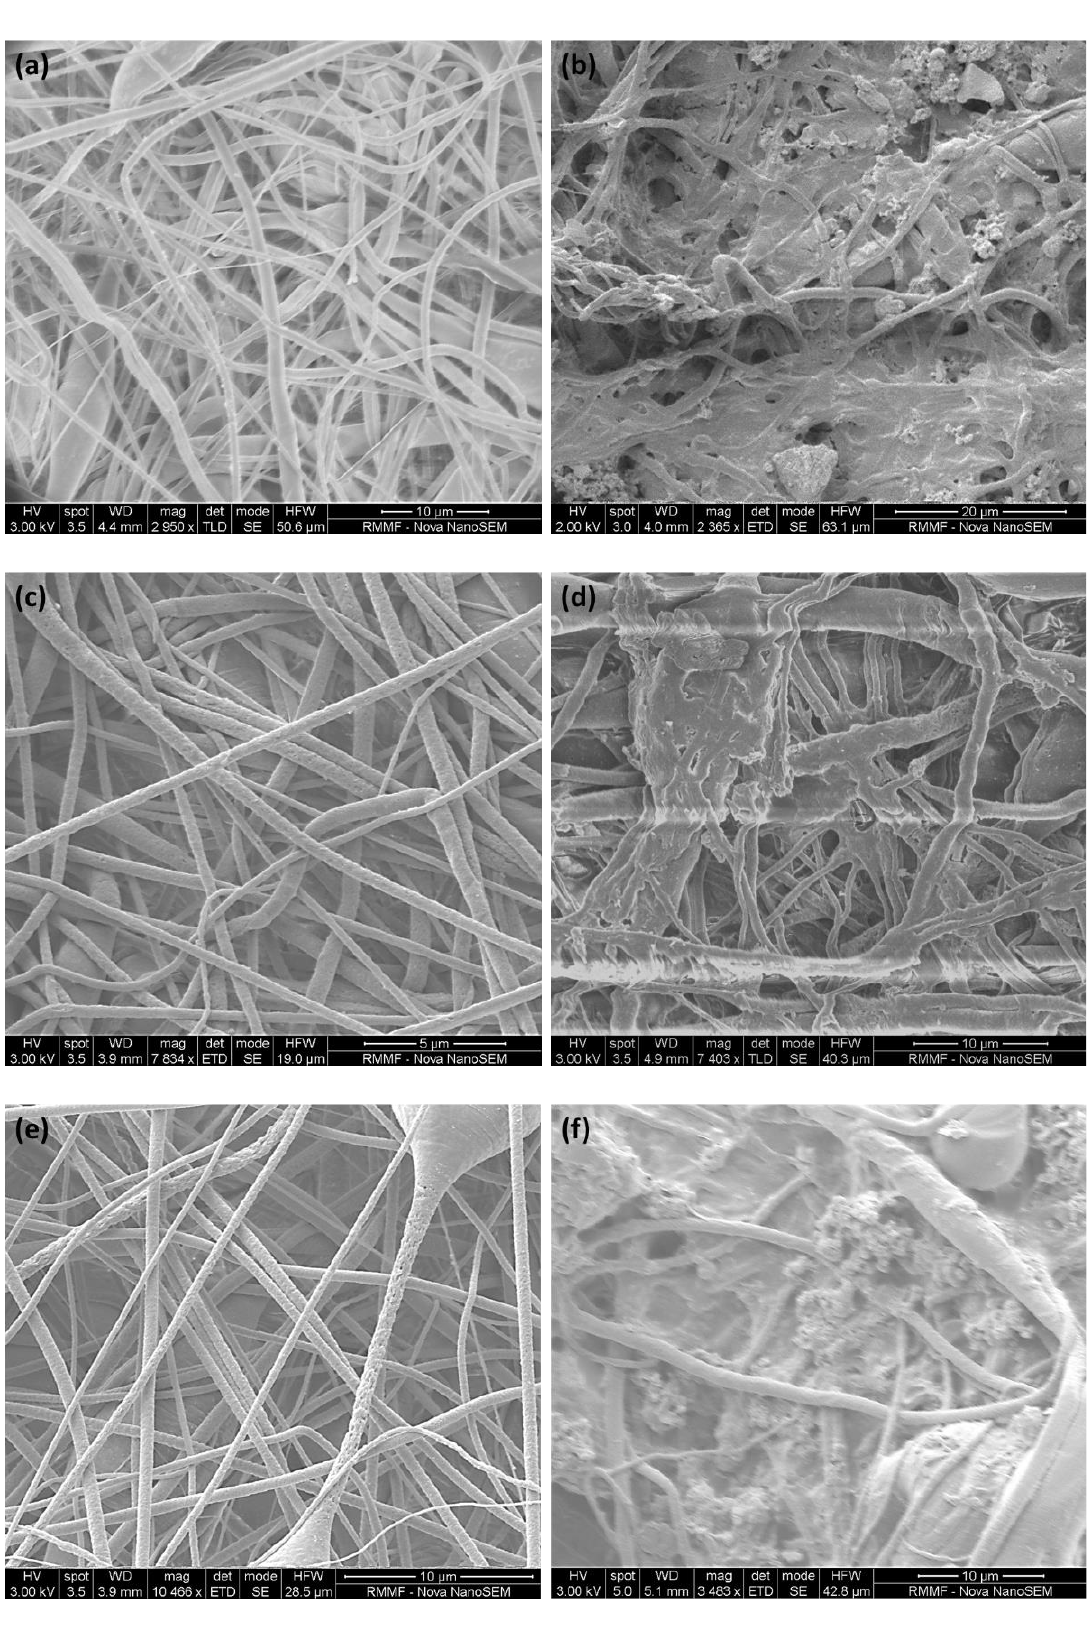
Figure 4. Morphology of the membrane before ( a , c , e ) and after ( b , d , f ) BSA filtration for antifouling study: ( a , b ) P, ( c , d ) CP, and ( e , f ) MCP. Table 1. Surface properties of the membranes before and after BSA filtration.